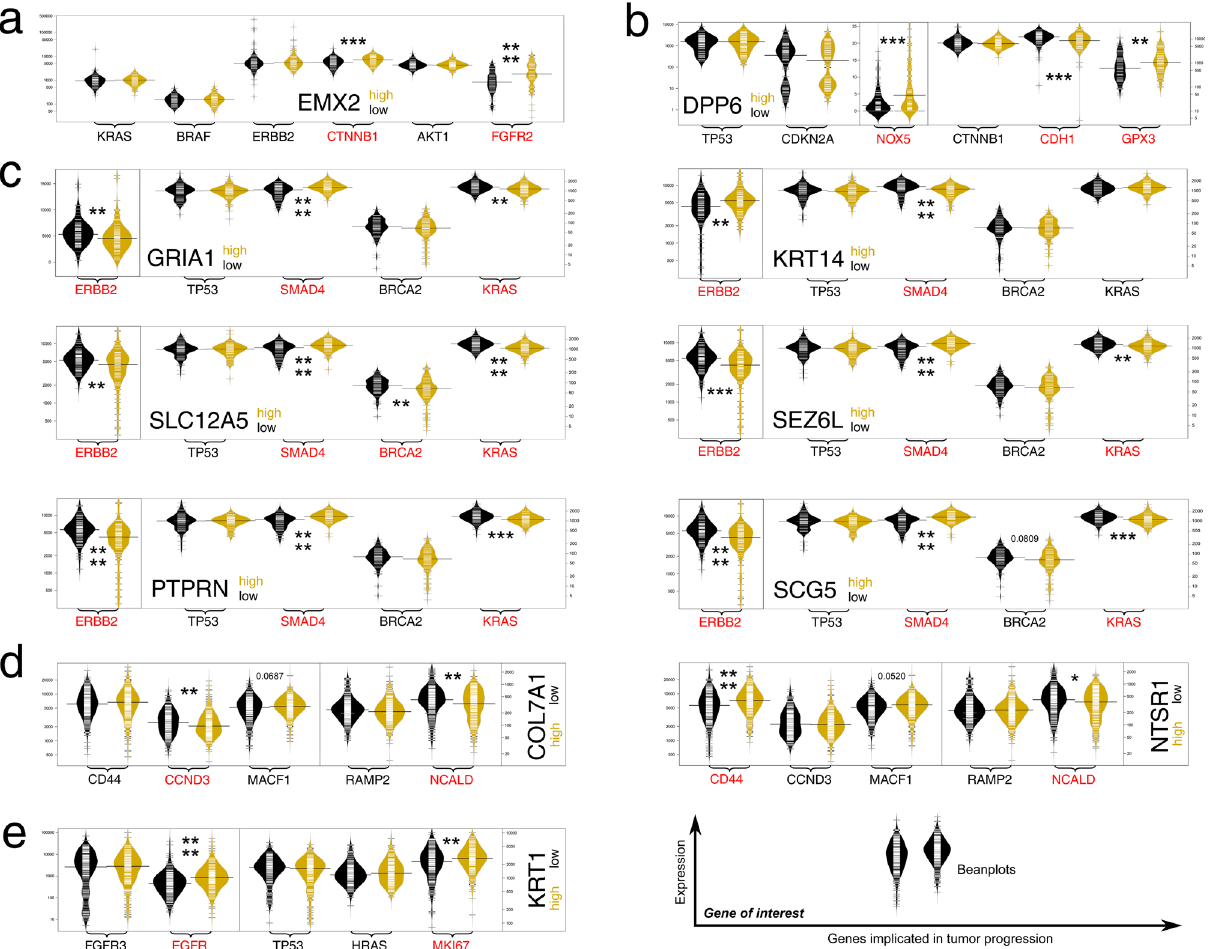
Figure 9. Co-dependence of post-ROC genes and tumor progression-related genes. Genes with an impact on patient survival in: ( a ) UCEC, ( b ) ESCA, ( c ) PAAD, ( d ) LUAD, ( e ) BLCA. In most cases, two separate scales (separated by a continuous line) are used on the Y axis due to large differences in expression